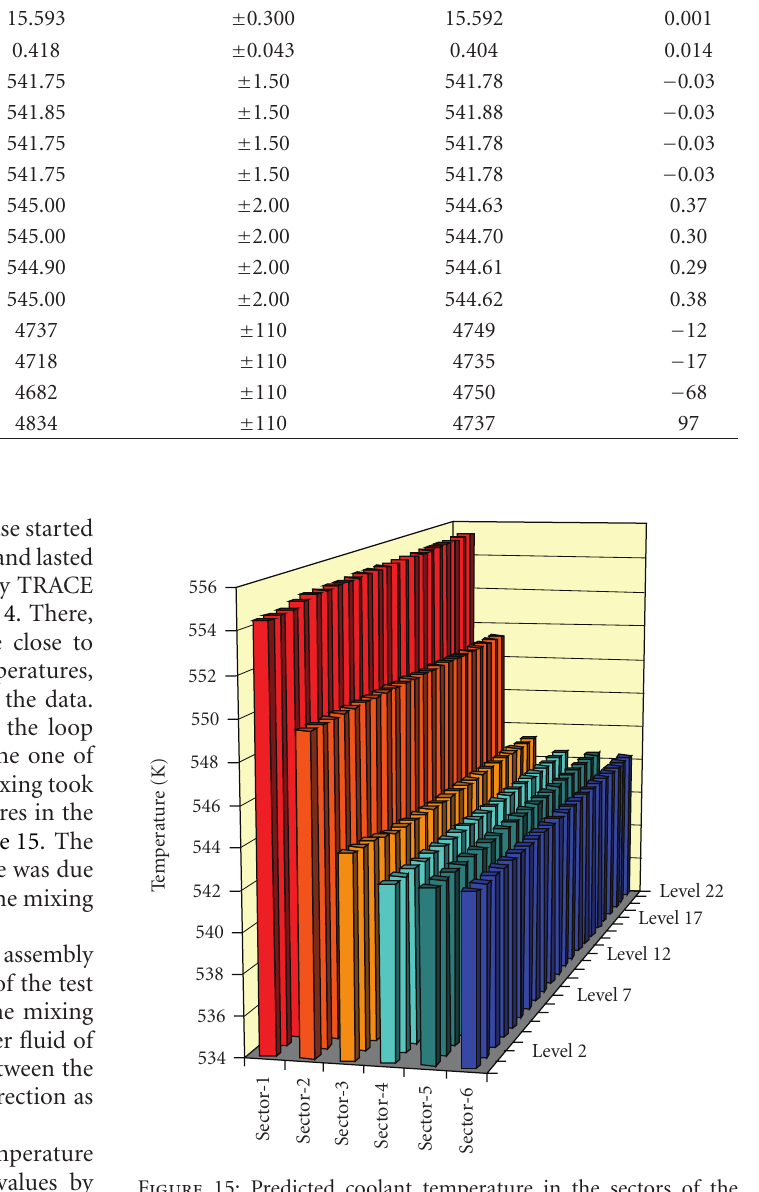
Figure 15: Predicted coolant temperature in the sectors of the downcomer (levels: 2 to